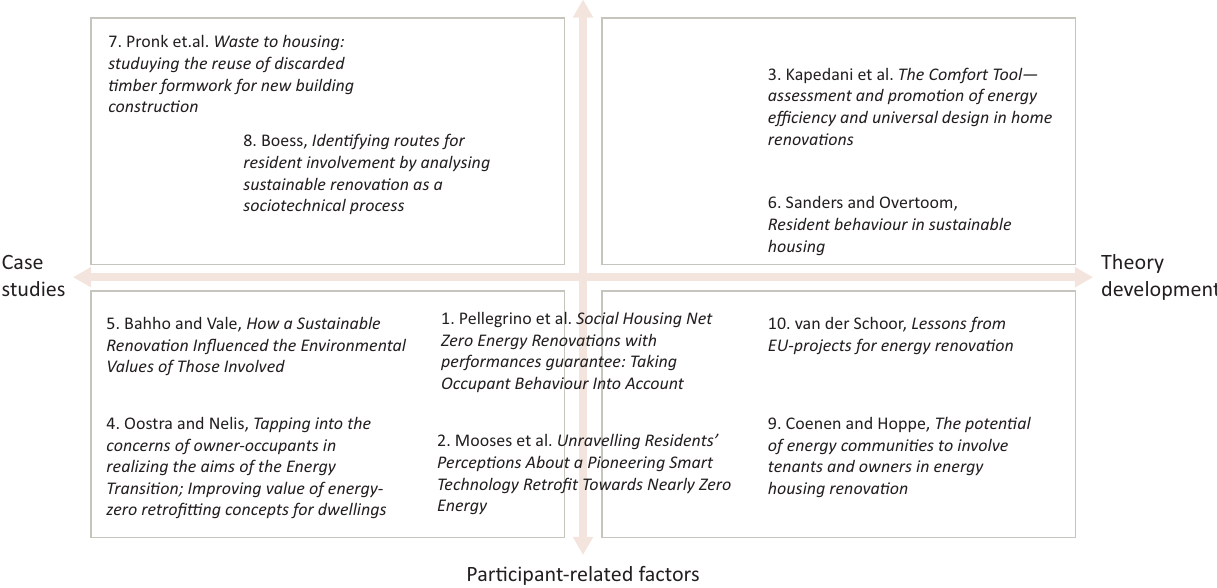
Figure 1. Diagram positioning the articles on two axes: Case studies versus theory development, and resident behaviour versus technological